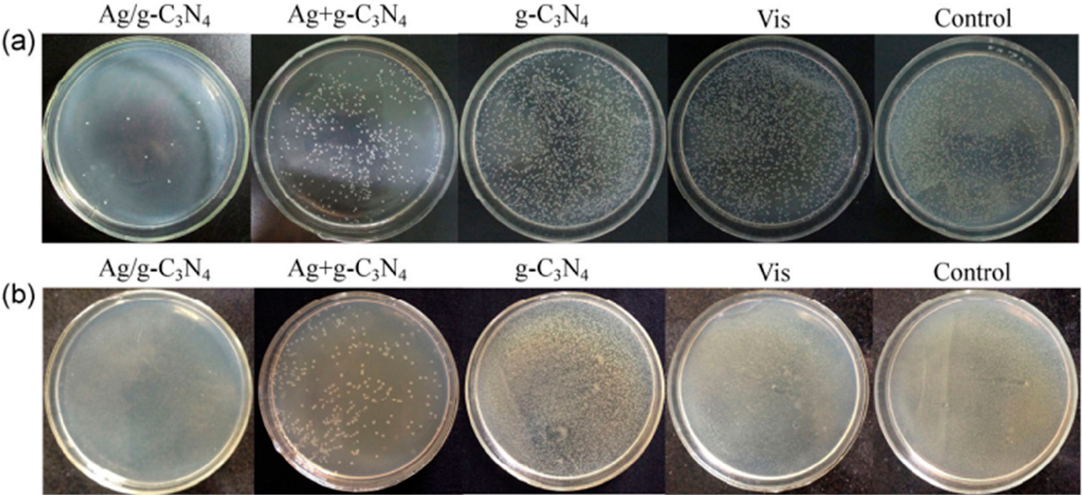
Figure 7. Antibacterial studies of g-C 3 N 4 , Ag NPs: g-C 3 N 4 or Ag/g-C 3 N 4 against ( a ) E. coli and ( b ) S. aureus.